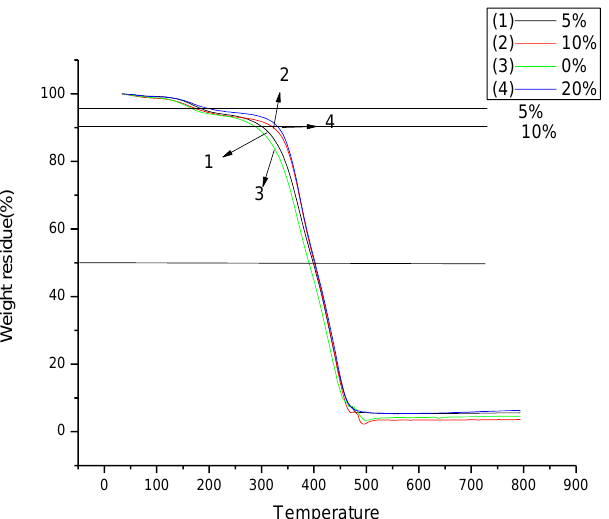
Figure 5. Effect of the absorbing agent loading on the thermal stability of the coating.